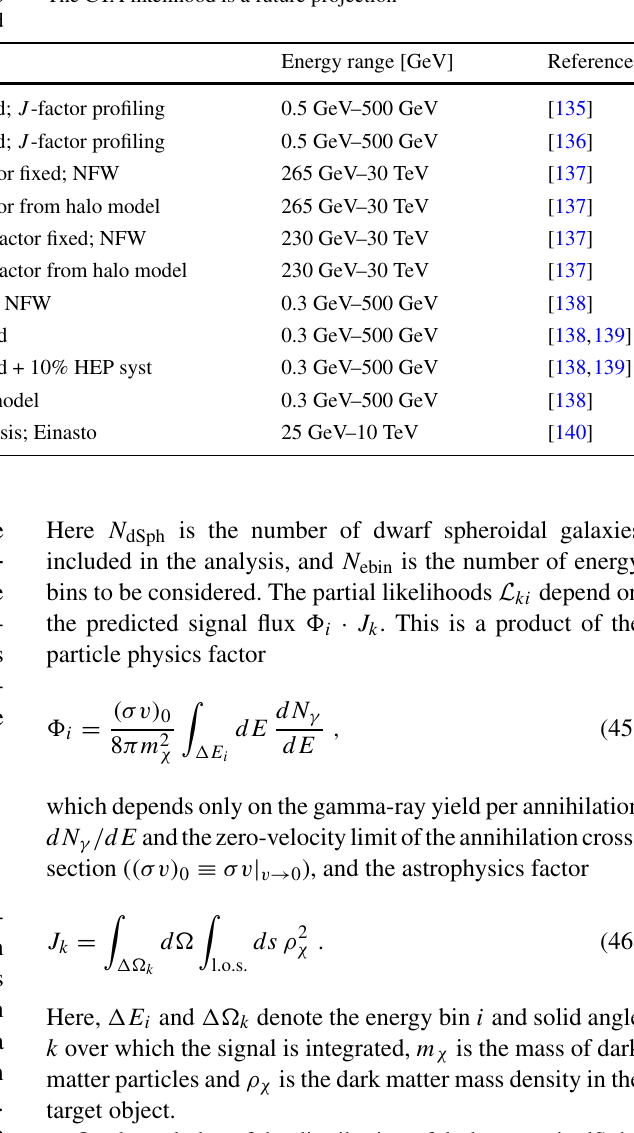
based on the dark matter profiles in the respective references (usually regular NFW profiles, and a contracted NFW in the case of the